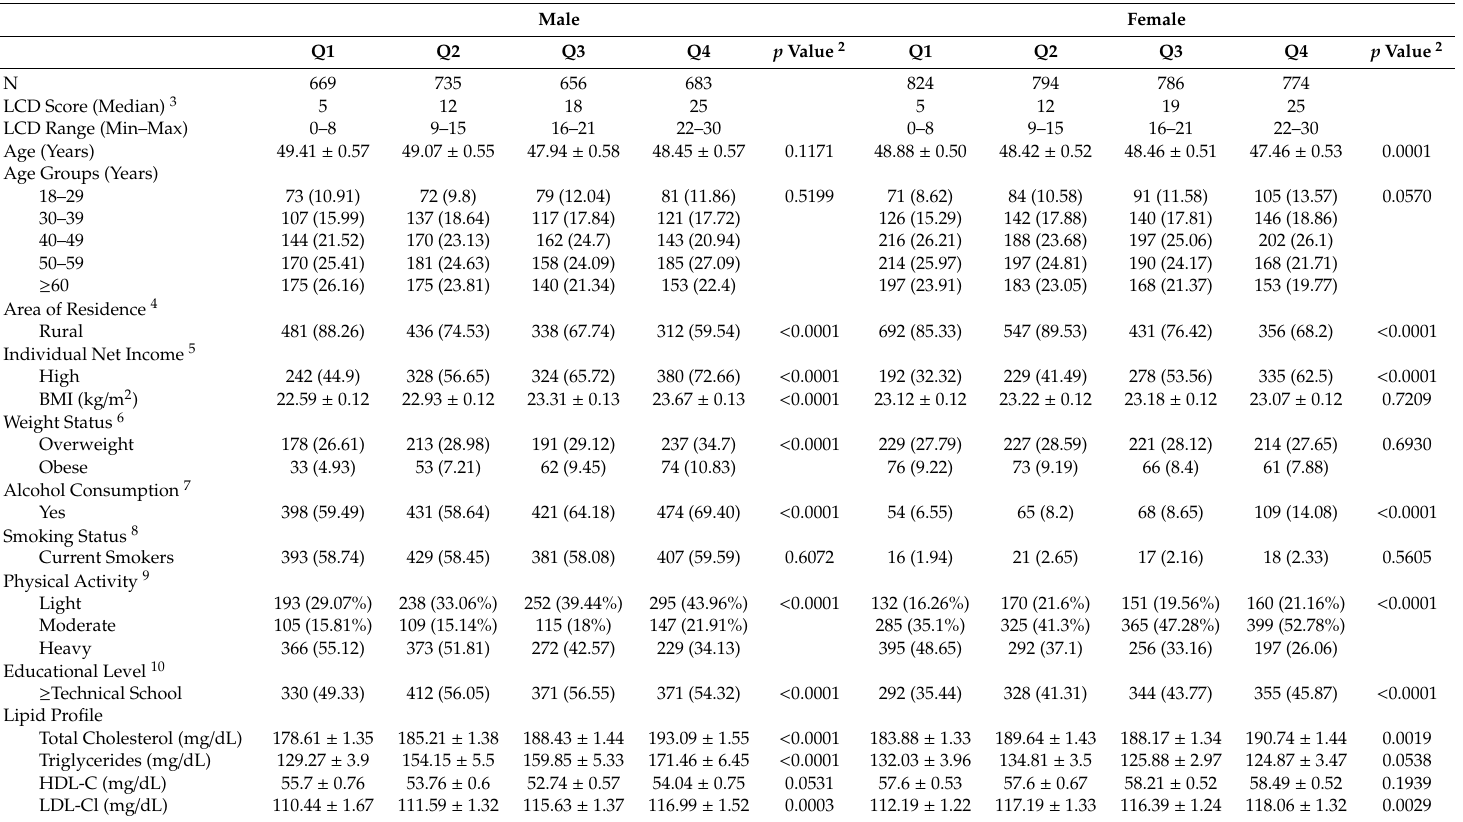
Table 2. General characteristics of Chinese adults according to the quartiles (Q) of the low-carbohydrate diet (LCD) scores, China Health and Nutrition Survey.